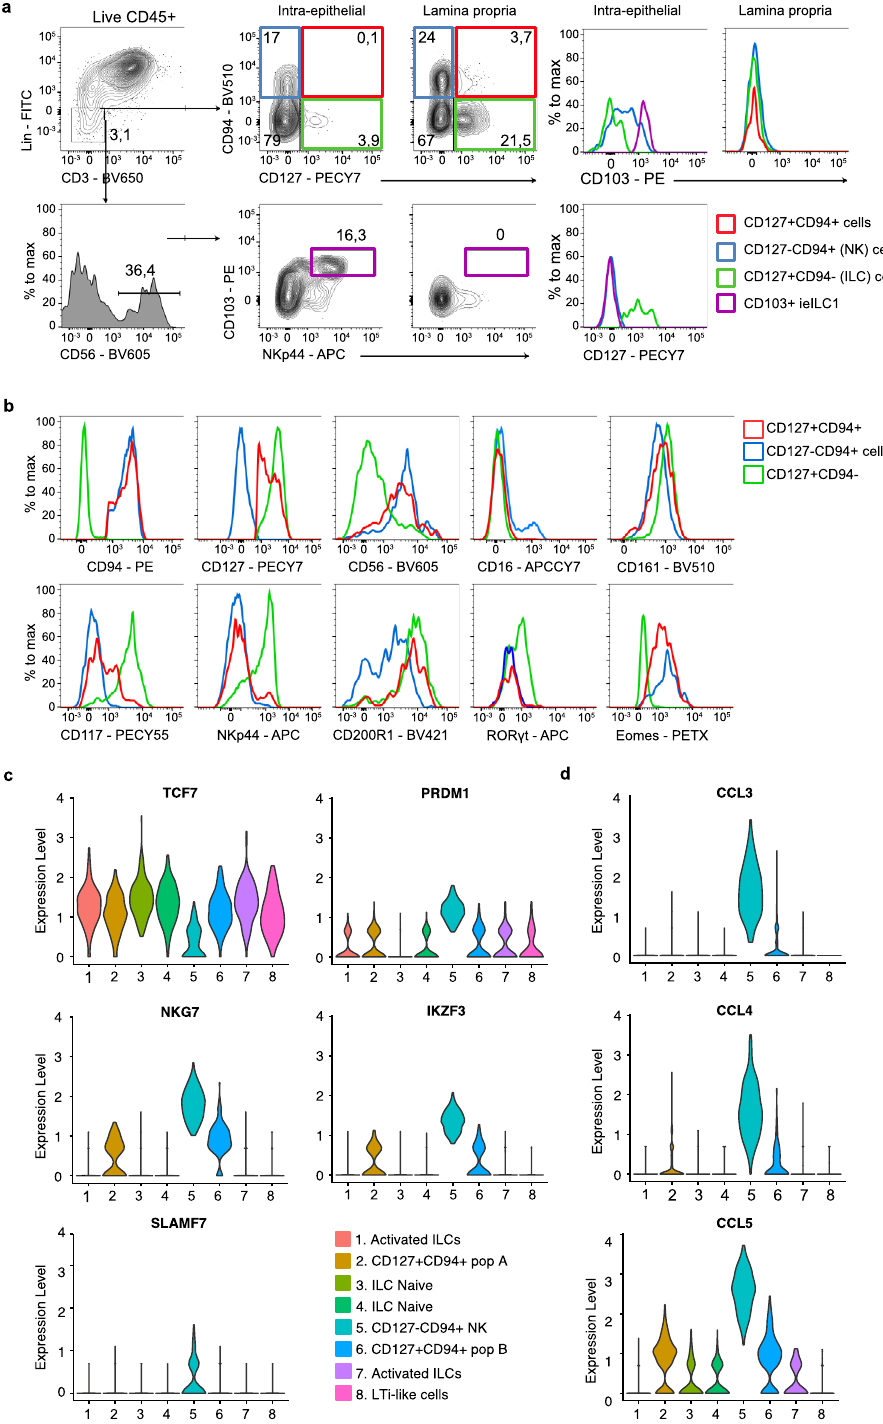
Fig. 2 CD127 + CD94 + cells localize in the lamina propria and express ILC and NK cell-related markers. a Flow cytometry analysis of lymphocytes in the intraepithelial compartment and lamina propria of the intestine. ieILC1 are gated for as live CD45 + lineage-CD56 + NKp44 + CD103 + (purple gate), NK cells (blue), conventional ILCs (green) and CD127 + CD94 + ILCs (red) are gated for as in Fig. 1a. Histograms depict the surface expression of CD103 and CD127 on the indicated populations. b Expression of surface phenotypes (CD94, CD127, CD56, CD16, CD161, CD117, NKp44, all at least N = 4) and intracellular Eomes ( N = 3) and ROR γ t ( N = 2) of intestinal CD127 + CD94 + cells (red), CD127 − CD94 + NK cells (blue) and CD127 + CD94 − ILCs (green). c , d Violin plots showing the expression of TCF7, PRDM1, NKG7, IKZF3 ( c ), CCL3, CCL4, and CCL5 ( d ) of clusters identi fi ed clusters of Fig. (Fig. S6a). However, the proportion of granulysin positive cells cells expressed granzyme B (Fig. 3g, h). Both in population B and was much higher in population B than in NK cells (Fig. 3f). In NK cells all granulysin positive cells co-expressed perforin. NK agreement with the scRNAseq results, both NK cells and cells in cells contain a larger percentage of perforin + granulysin − cells population B expressed high perforin protein levels but only NK (Fig S6b). Of note, CD16 − and CD16 + NK cells expressed similar